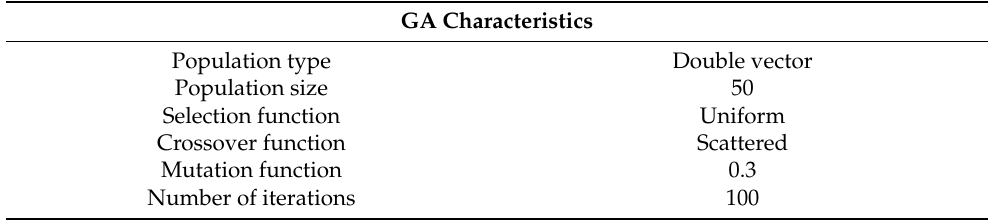
Table 2. GA characteristics.